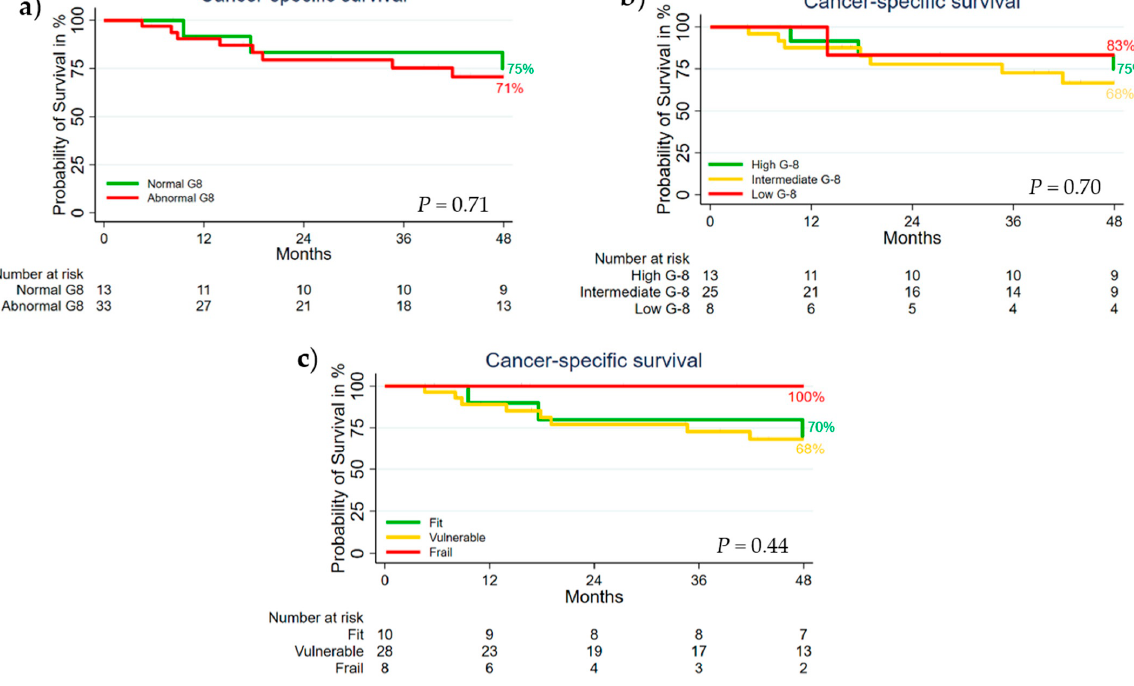
Figure 2. Kaplan–Meier plots of cancer-specific survival in ( a ) the normal vs. abnormal G-8 groups, ( b ) the high, intermediate, and low G-8 groups, and ( c ) the fit, vulnerable, and frail G-8 and HGST combination groups. Table 2. Univariate analysis and Cox multivariate regression model in patients with localized non-small cell lung cancer who were treated with stereotactic body radiation therapy.